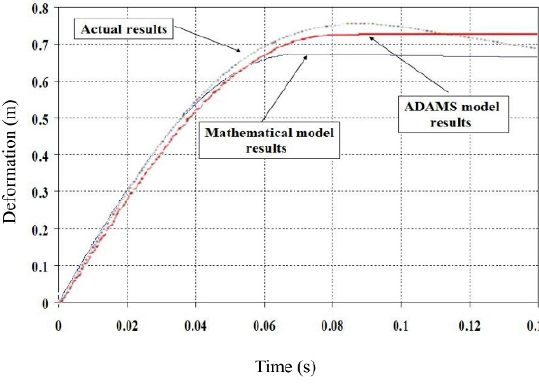
Figure 10. Deformation of the front-end